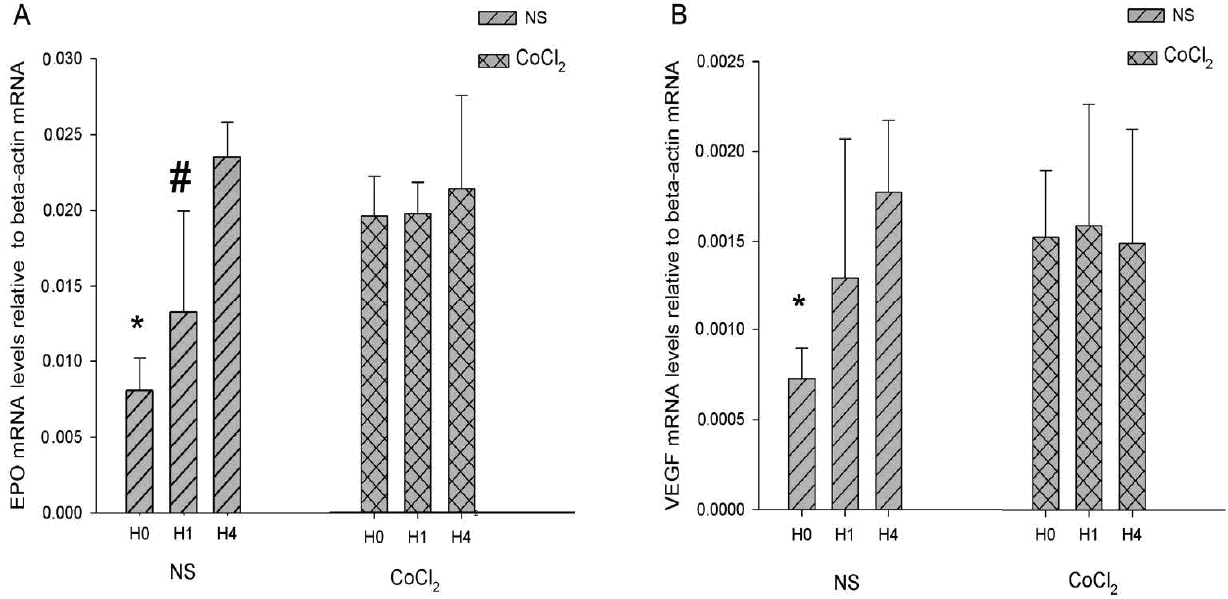
Figure 5. Real-time PCR analysis erythropoietin ( EPO ) and vascular endothelial growth factor ( VEGF ) mRNA in hippocampus. ( A ) The EPO mRNA level relative to β - actin mRNA; ( B ) the VEGF mRNA level relative to β -actin mRNA. ( n = 6; * p < 0.05 vs. H1 and H4 in NS group; # p < 0.05 vs. H0 and H4 in NS